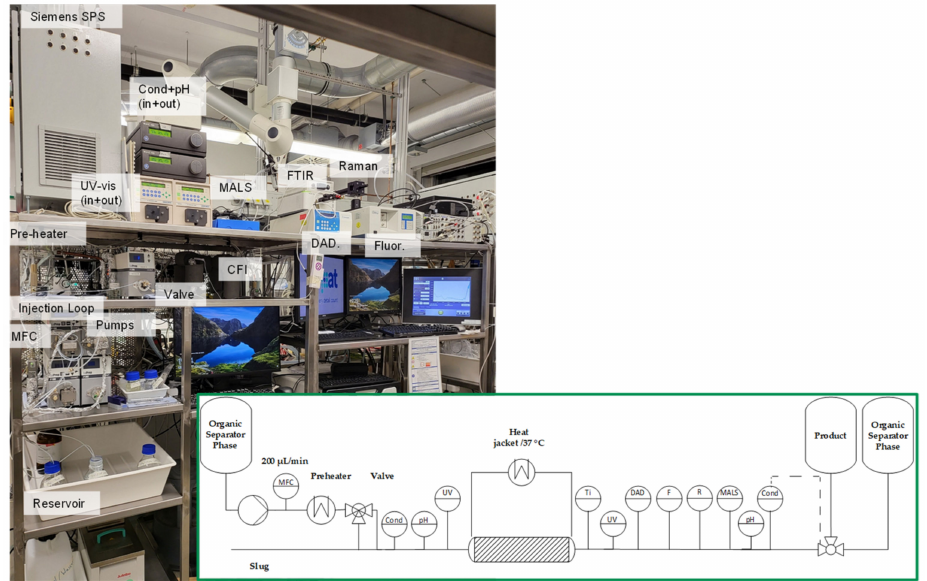
Figure 6. Setup of the plant, including